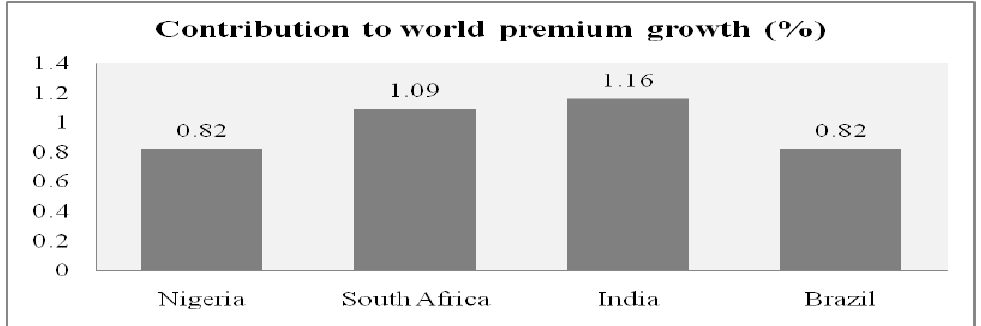
Figure 1. Premium contribution to world by Nigeria and other countries. Source: Computed from IMF data on insurance industry report for Nigeria.